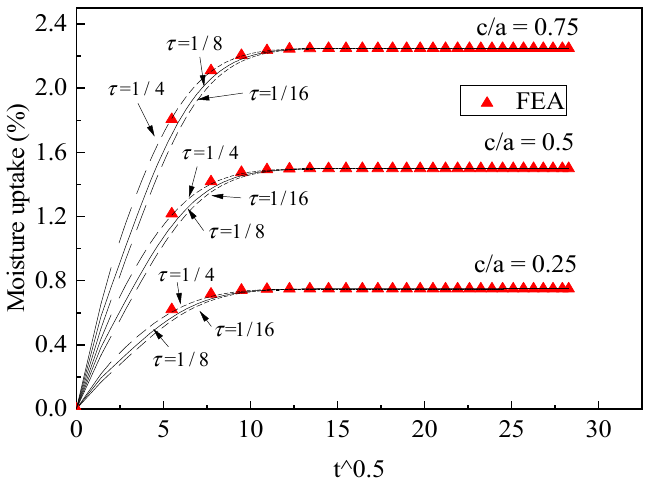
Figure 9. Validation of the three-phase diffusion model, D 1 > D 2 , c / a < 1.